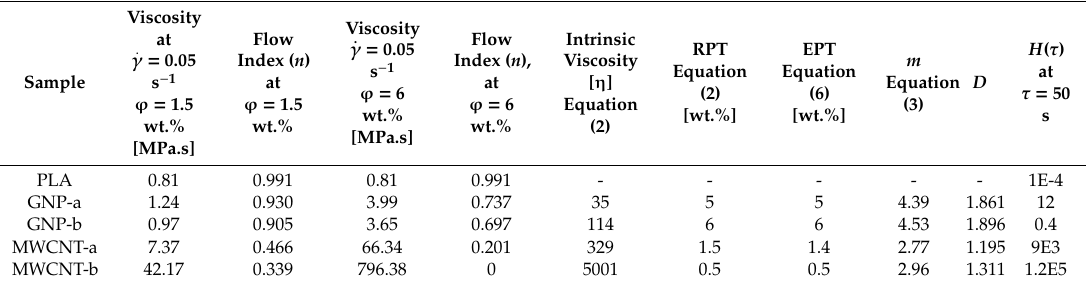
Figure 1. Viscosity vs. shear rate of NC-a and NC-b series comparing nanocomposites with MWCNTs and GNPs with the neat PLA for: ( a ) 1.5 wt.% and ( b ) 6 wt.% filler contents. . γ = Table 2. Viscosity at 0.05 s − 1 , flow index (n) and other dispersion characteristics of NC-a and NC-b, filled with 1.5 and 6 wt.% GNP and